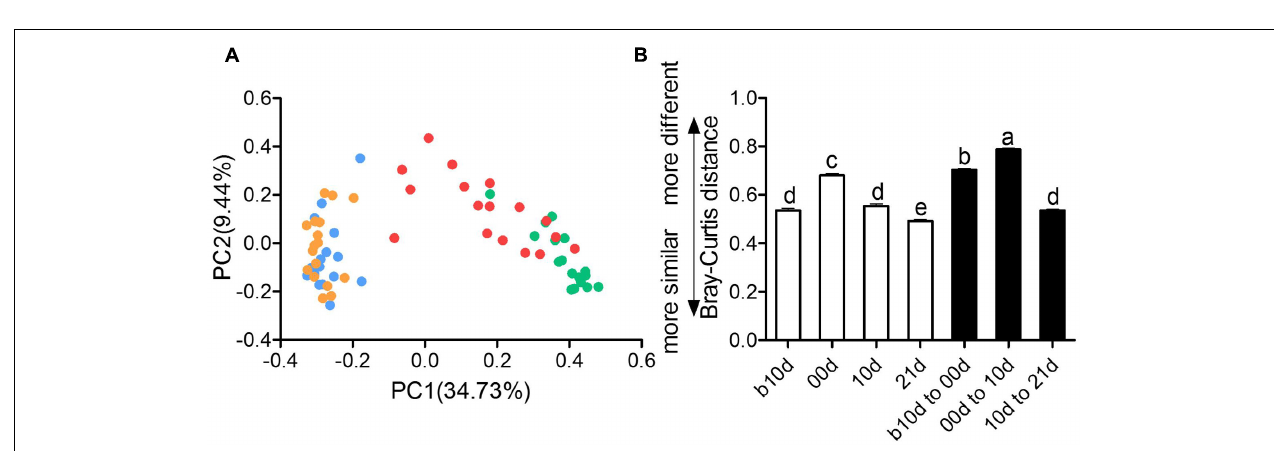
FIGURE 3 | Variations in alpha diversity of the piglets. (A) Comparisons of Shannon diversity indices among different age piglets by paired sample Wilcoxon signed-rank test. (B) Comparisons of the number of observed OTUs among different age piglets by paired sample Wilcoxon signed-rank test. (C) Comparisons of Shannon diversity indices between T1 and T2 by Mann–Whitney test. (D) Comparisons of the number of observed OTUs between T1 and T2 by Mann–Whitney test. Both alpha diversity metrics were calculated upon the rarified OTU subsets, using 13,000 sequences per sample with 1,000 replications. In all panels, boxes represent the interquartile range (IQR) between the first and third quartiles. The lines inside boxes represent the median. Whiskers denote the lowest and highest values within 1.5 IQR from the first and third quartiles, respectively. ∗ P < 0.05, ∗∗ P < 0.01, ∗∗∗ P < 0.001 (with FDR adjust).